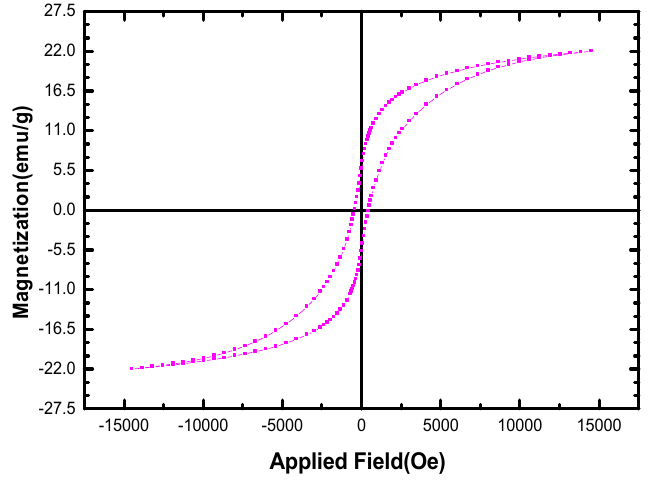
Figure 3. Vibrating Sample Magnetometery (VSM) of activated carbon/CoFe 2 O 4 nanocomposite.